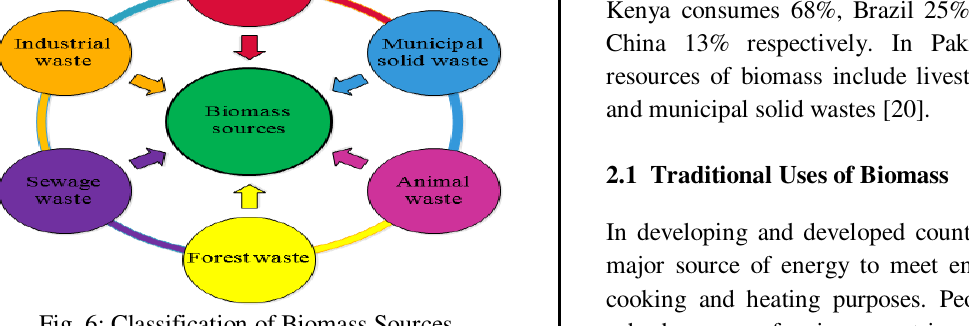
Fig. 6: Classification of Biomass